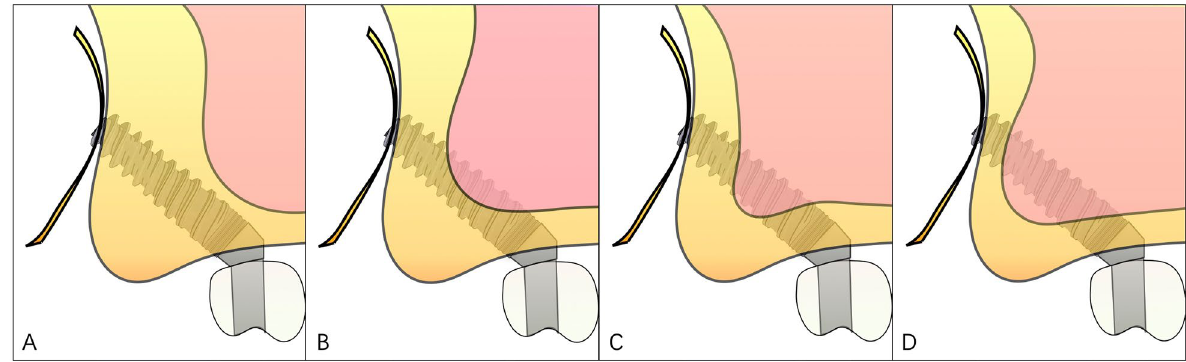
Fig. 9 Four categories of relationship between the body of the implant and the sinus cavity. A No implant body in the sinus cavity. B One side of implant anchored in the posterior sinus wall and the other side of implant in the sinus cavity. C Less than 1/2 of the whole implant body in the sinus cavity. D Greater than 1/2 of the whole implant body in the sinus cavity